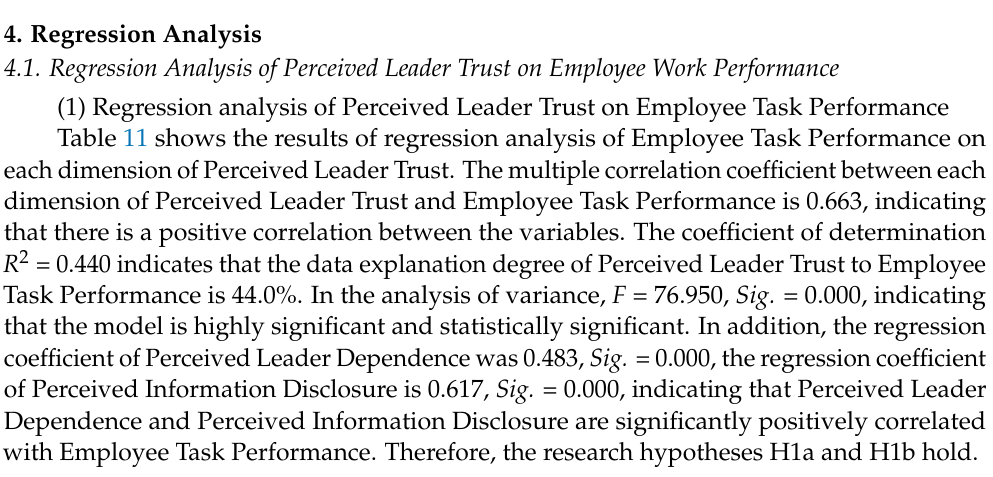
Table 11. Regression Analysis of Perceived Leader Trust on Employee Task